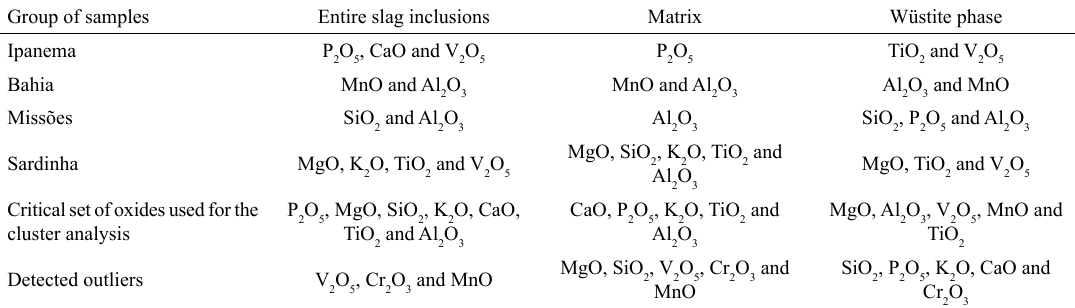
Table 5: Characteristic components present in the slag inclusions, including their main microconstituents (matrix and wüstite), for each group of samples Group of